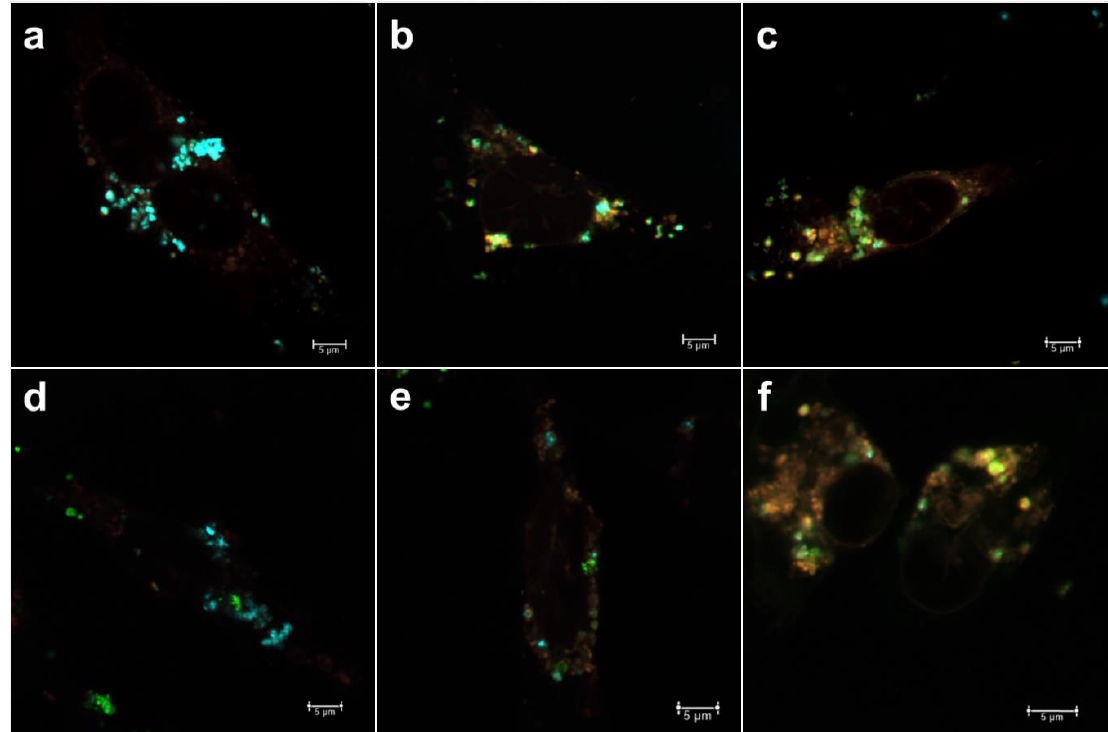
Figure 4. MSNs (cyan) loaded with DiD (red) and endosomal markers (green) ( a – c ) EEA1 (0.1, 0.5, 1.0 wt % loading of DiD, respectively) and ( d – f ) Rab7 (0.1, 0.5, 1.0 wt % loading of DiD, respectively) at 48 h.